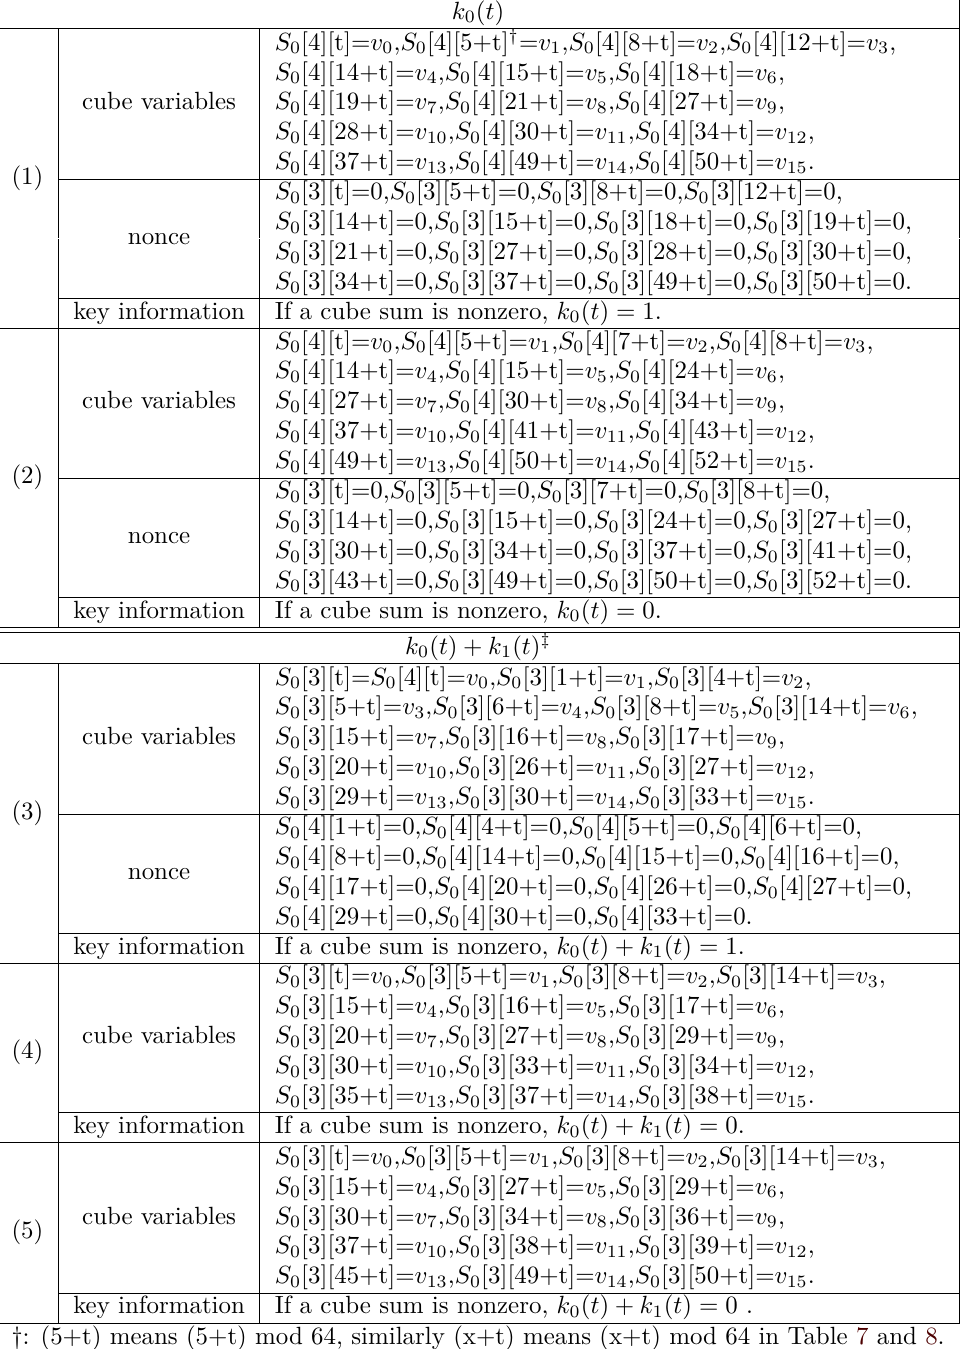
Table 7: Parameters Set for Attack on the 5-round Initialization of Ascon k 0 ( t